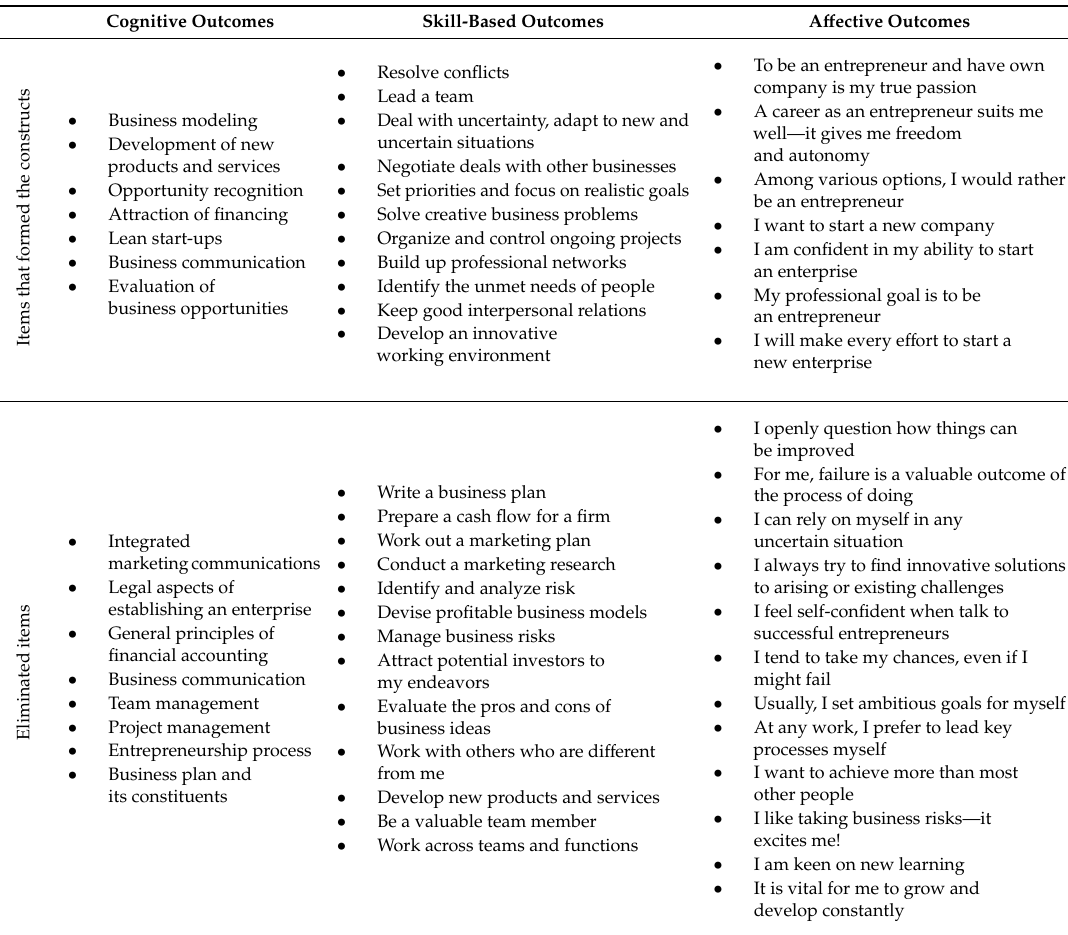
Table A1. Items Eliminated during the Purification